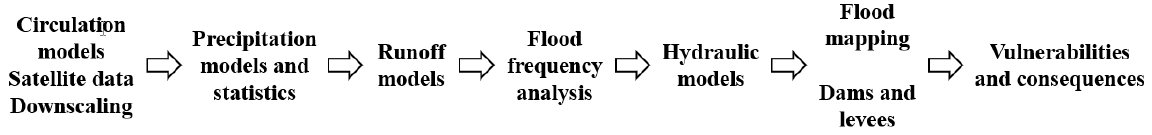
Figure 1. Reference diagram showing locations of riverine and coastal flood risks.